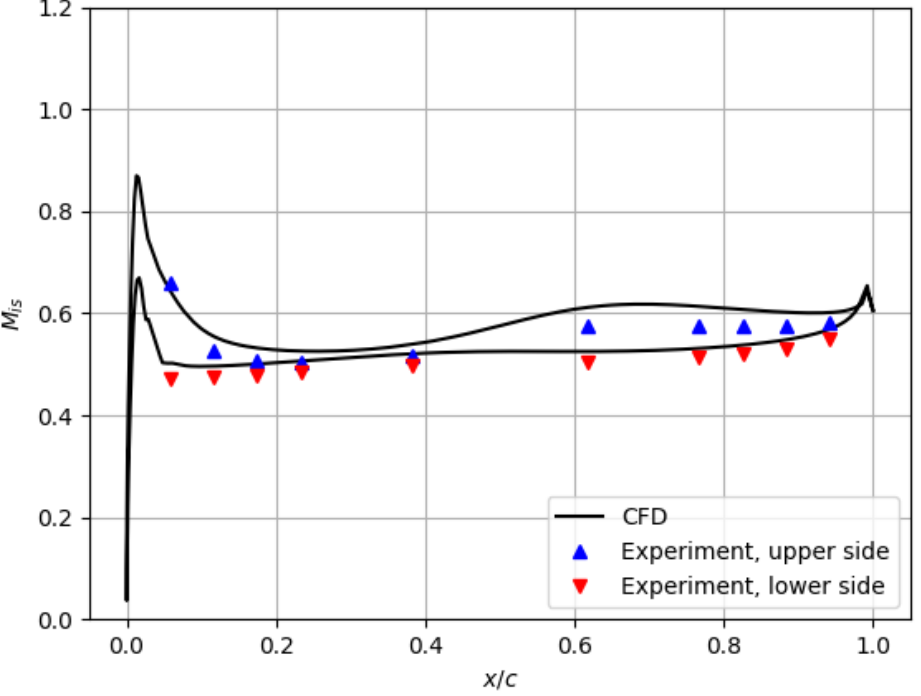
Figure 18. Isentropic Mach number distribution along the middle blade (blade no. 3) for α = 3°. Figure 19 shows the distribution of the isentropic Mach number along blades no. 2, 3, and 4 for α = − 3°, 0° and 3°. One can see that blade no. 2 is front loaded for negative α and the loading becomes more even with increasing the α . Opposite effect, although a bit weaker, can be seen at the blade no.